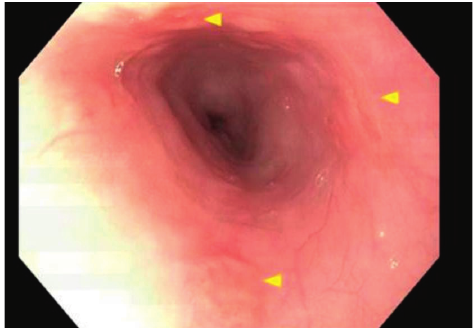
Figure 4: Upper endoscopy with gross visualization of shallow ulcerations in the esophageal mucosa.